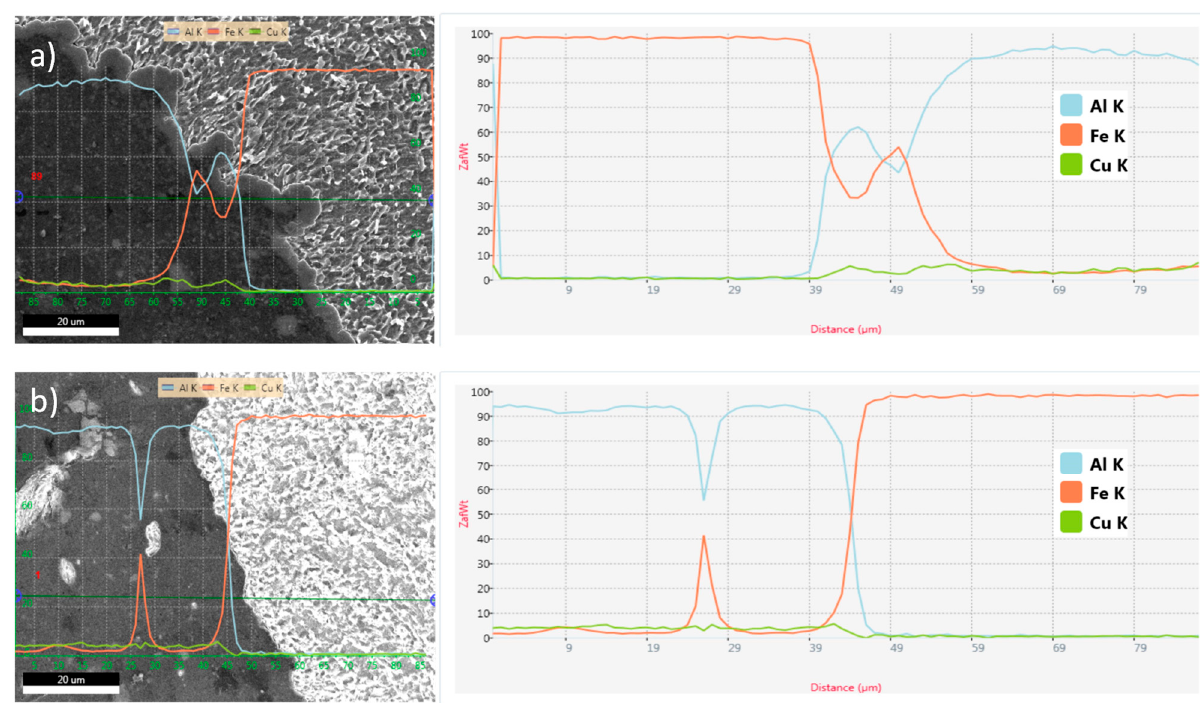
Figure 9. SEM images and line analysis of Fe and Al around the Al/steel interface at ( a ) 25 mm/min and 250 rpm and ( b ) 50 mm/min and 200 rpm.